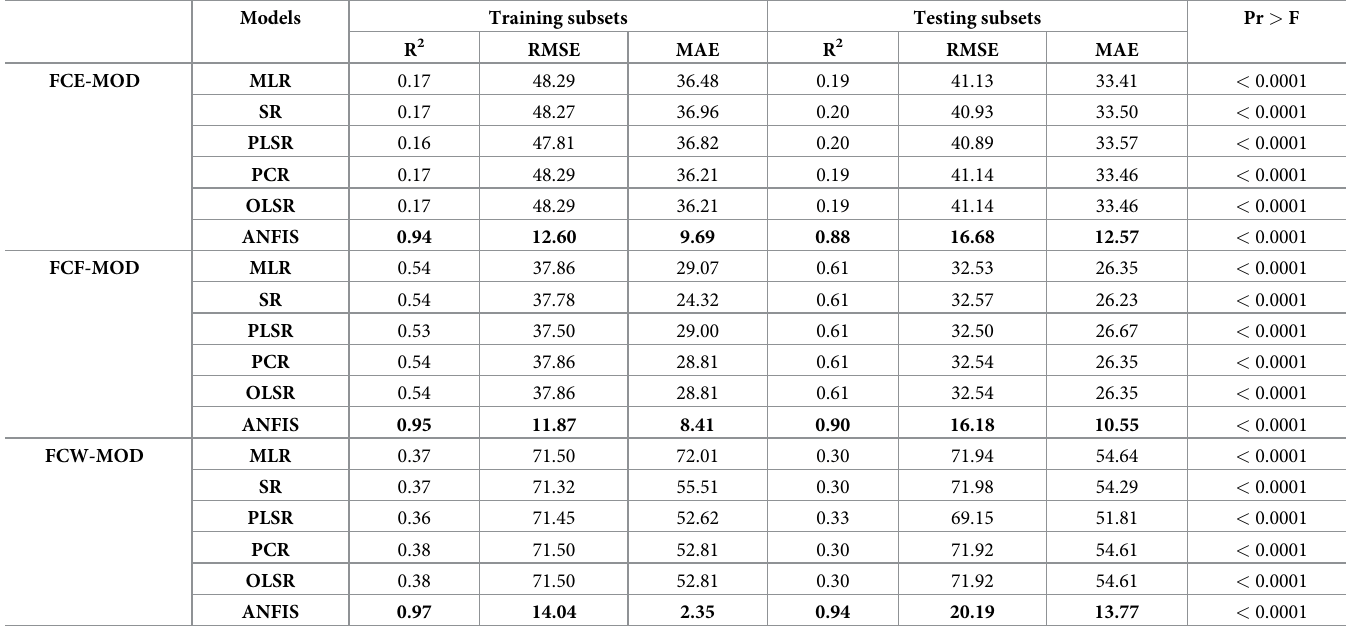
R 2 : coefficient of determination, RMSE: root mean square error, MAE: mean absolute